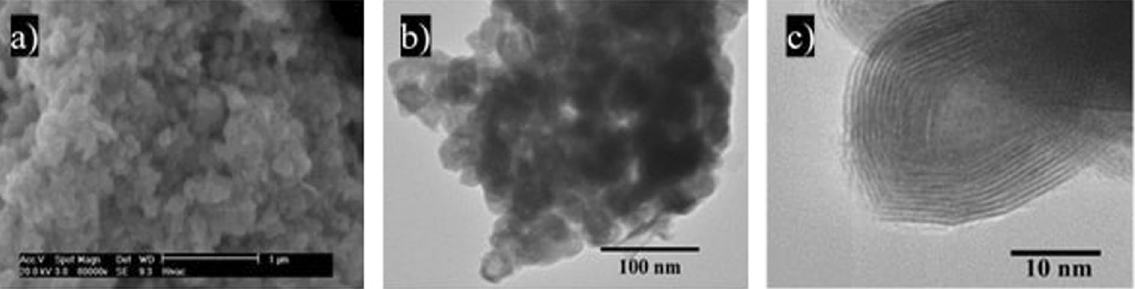
Figure 1. SEM ( a ) and TEM ( b , c ) images of IF-WS 2 nanoparticles.